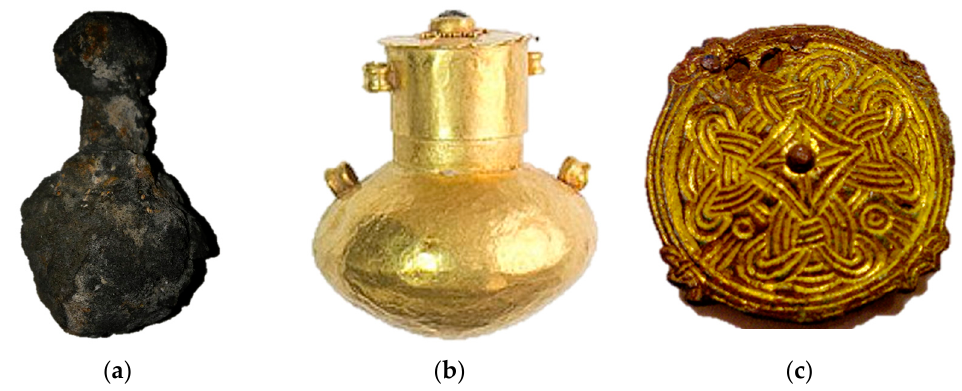
Figure 1. Photos of the studied cultural heritage objects: ( a ) the fragment of remains of ancient bireme; ( b ) golden vial of a Sarmatian woman; and ( c ) fibulae.